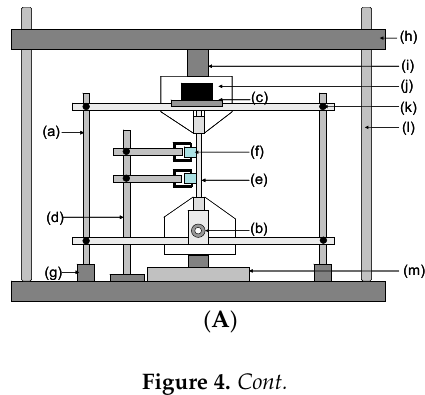
Figure 4. Cont. Figure 4.